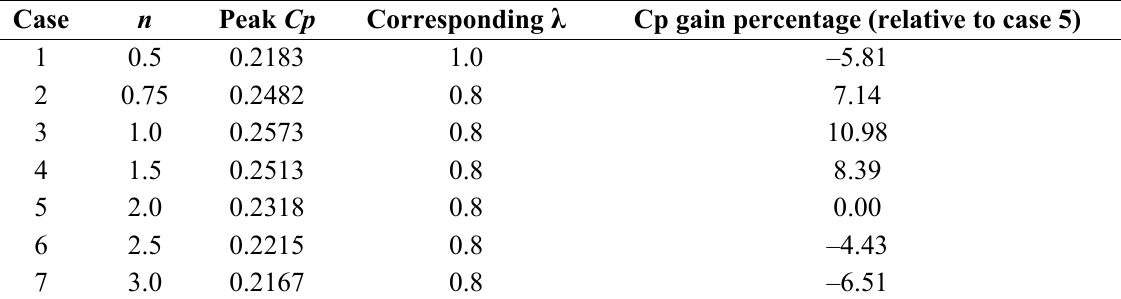
Table 2. The maximum coefficient of power for each case.